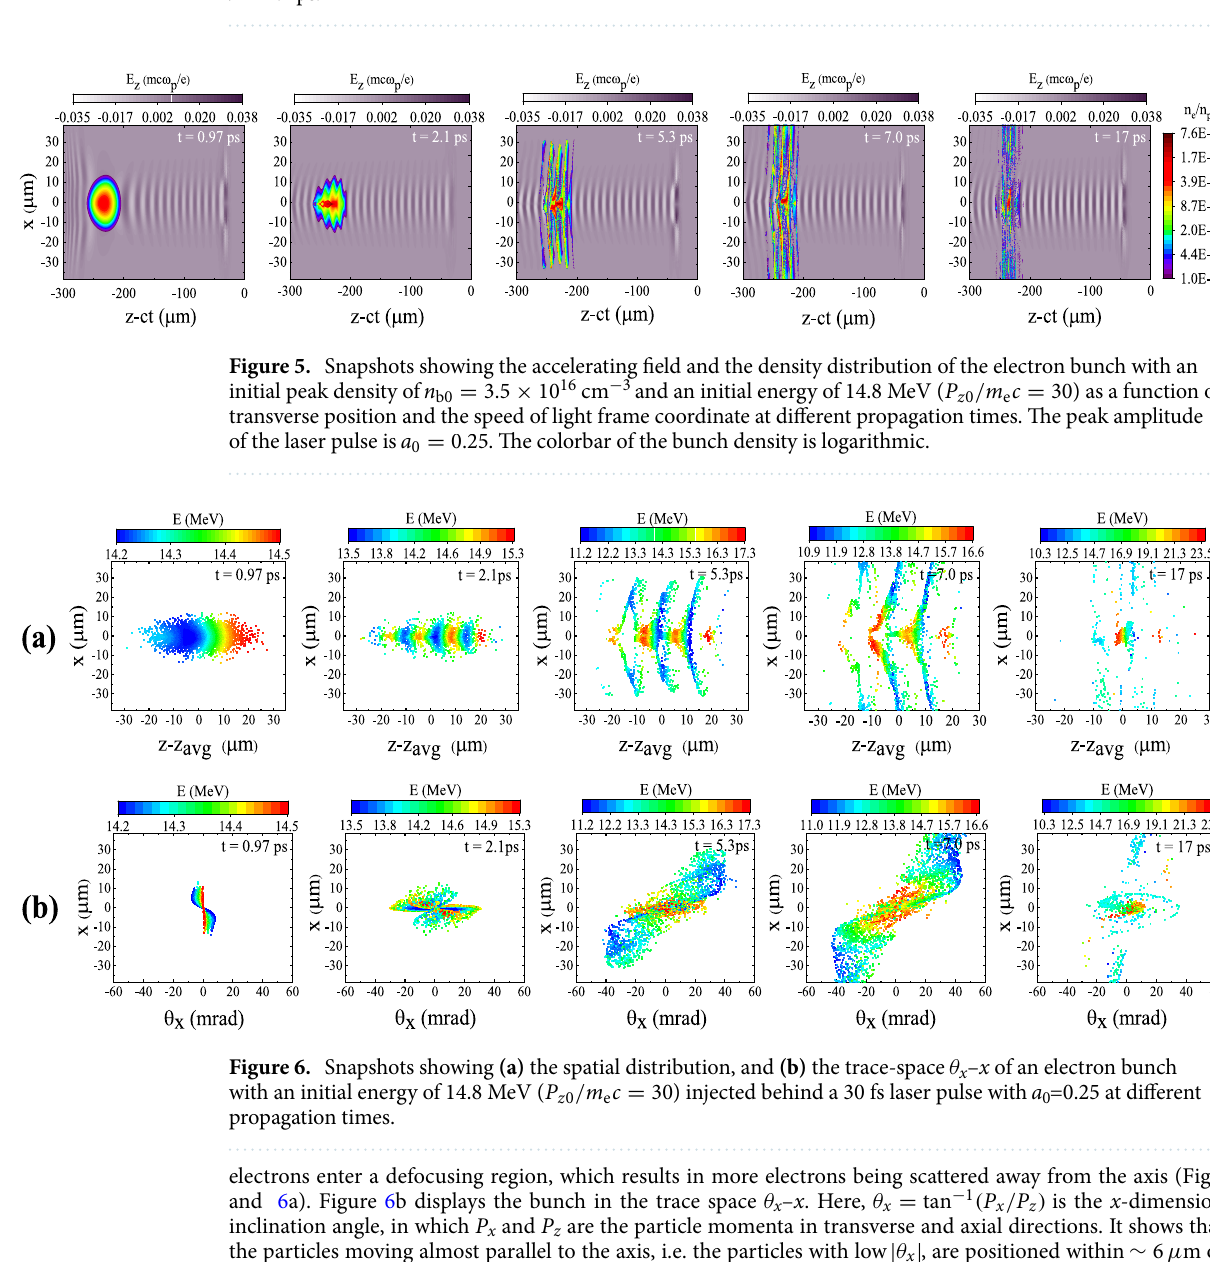
3.5 10 16 cm − 3 at = ×